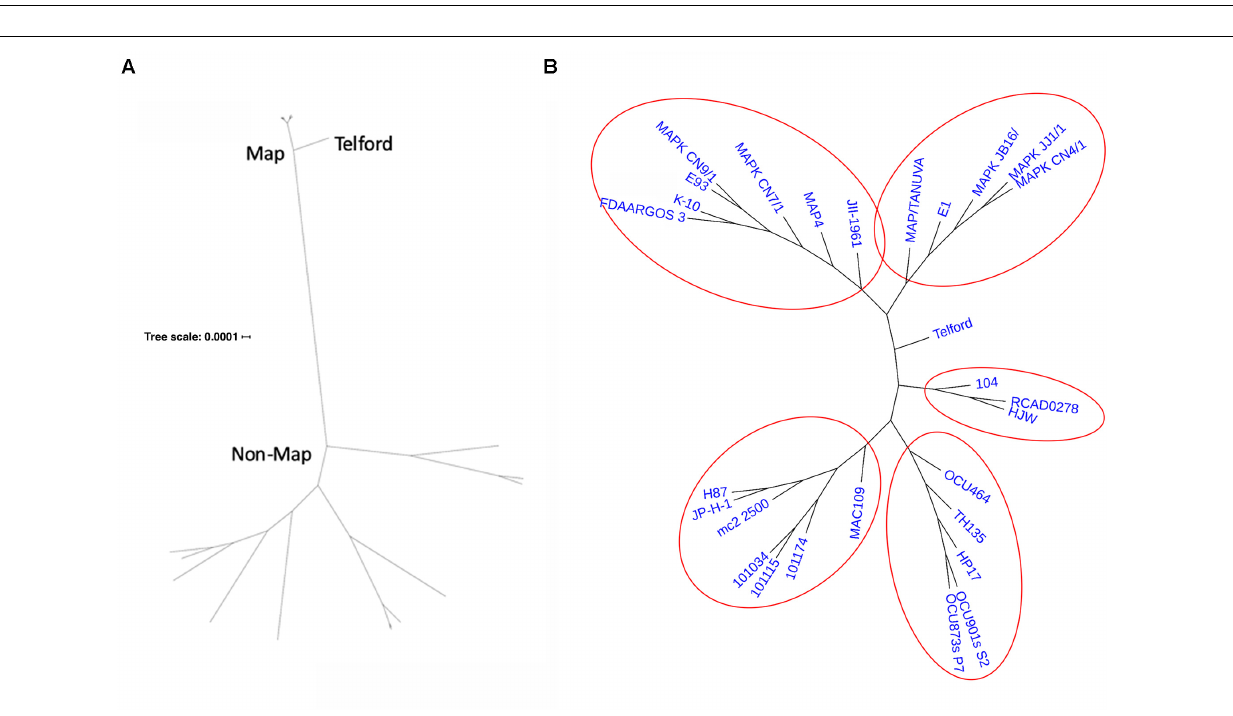
FIGURE 8 | Core gene phylogeny inferred from Roary analysis of 28 M. avium strains with RAxML and corrected for horizontal gene transfer by ClonalFrameML. (A) Unrooted phylogeny visualized using iTOL with respect to the branch length distance. (B) Unrooted phylogeny visualized in iTOL without branch length. This enables easier visualization of the tree topology especially for the Map strains. Map type II strains appear to form 2 separated clades. Clusters are circled in red and the bootstrap value calculated with RAxML is > 90%. Branch length was computed by the maximum likelihood algorithm and represents substitutions per site.